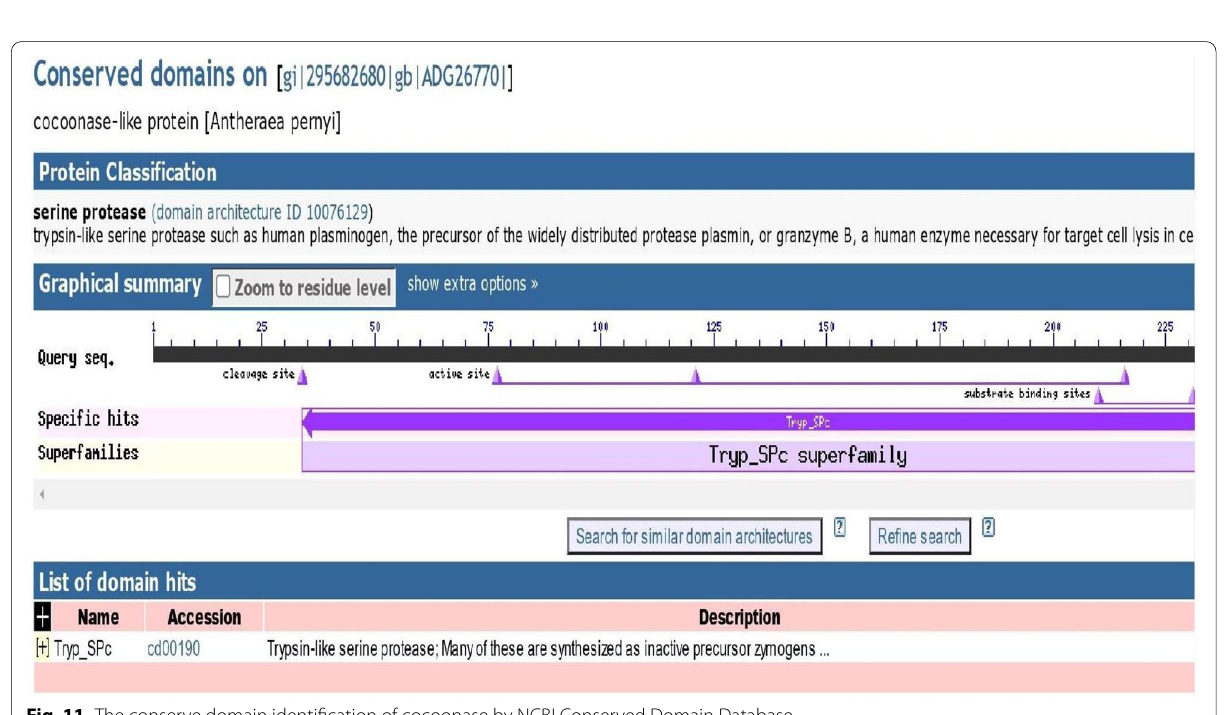
Fig. 11 The conserve domain identification of cocoonase by NCBI Conserved Domain